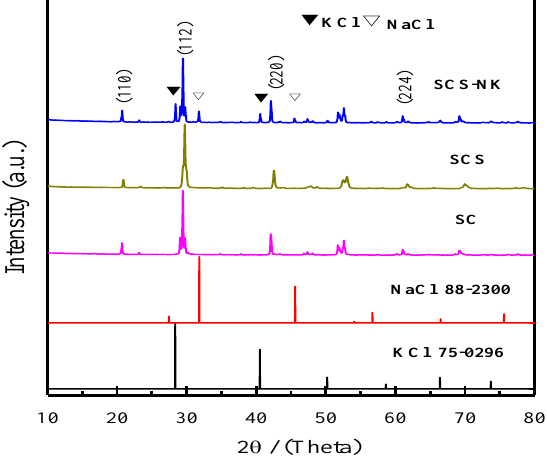
Figure 1. XRD patterns of SrCeO 3 (SC), SrCe 0.9 Sm 0.1 O 3-α (SCS) and SrCe 0.9 Sm 0.1 O 3-α -NaCl-KCl (SCS-NK) powder.